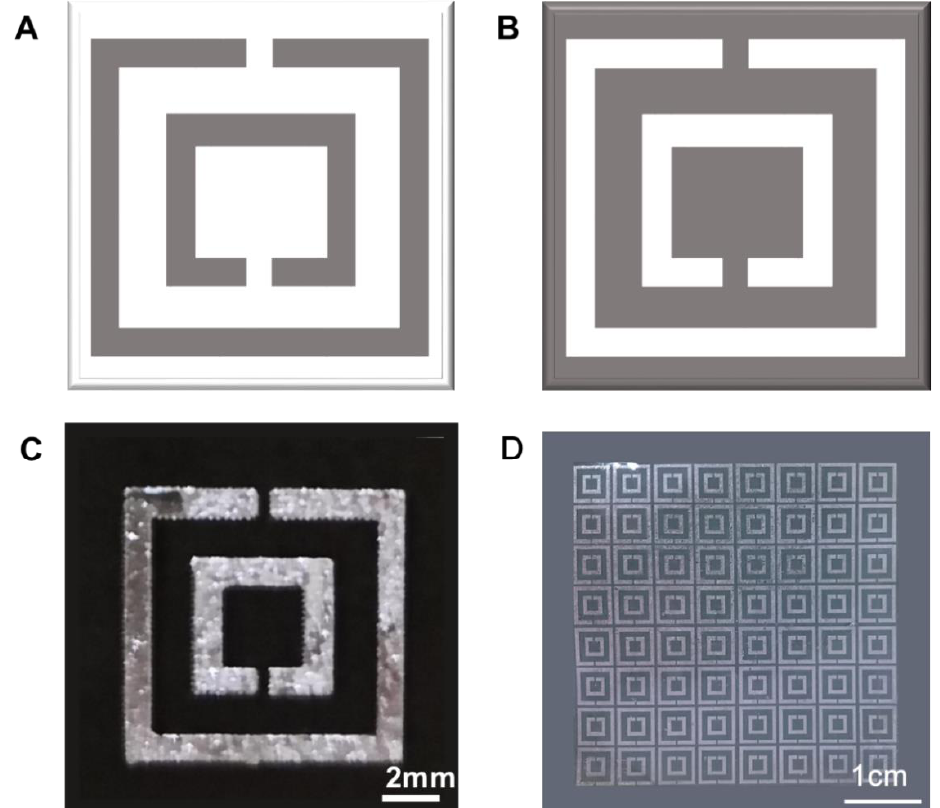
Figure 9. Metamaterial. Schematic diagram of split-ring resonator (SRR) ( A ) and complementary split-ring resonator (CSRR) ( B ), where the gray color represents metal and the white represents gaps. ( C ) An SRR unit fabricated by liquid metal. ( D ) SRR arrays fabricated by liquid metal.